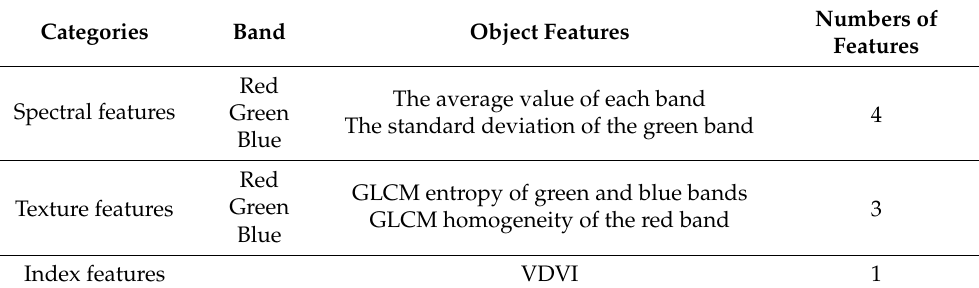
Table 2. The specific and optimal object features used in the